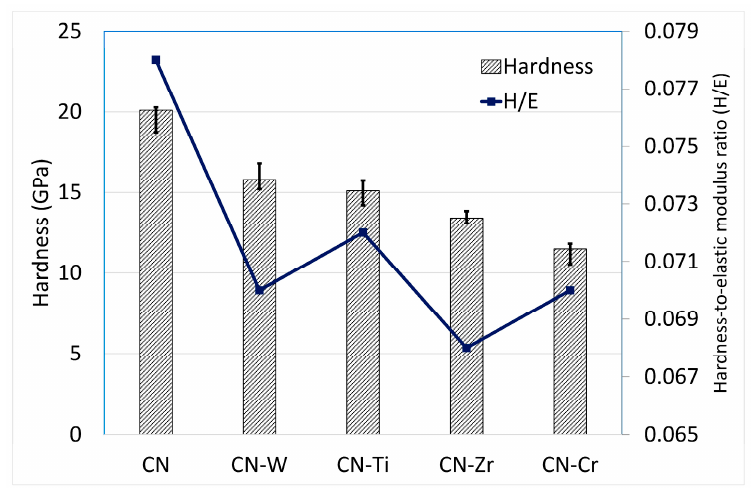
Figure 6. Hardness and hardness-to-elastic modulus ratio (H/E) values of CNx and 6 at. % metal-doped CNx coatings.